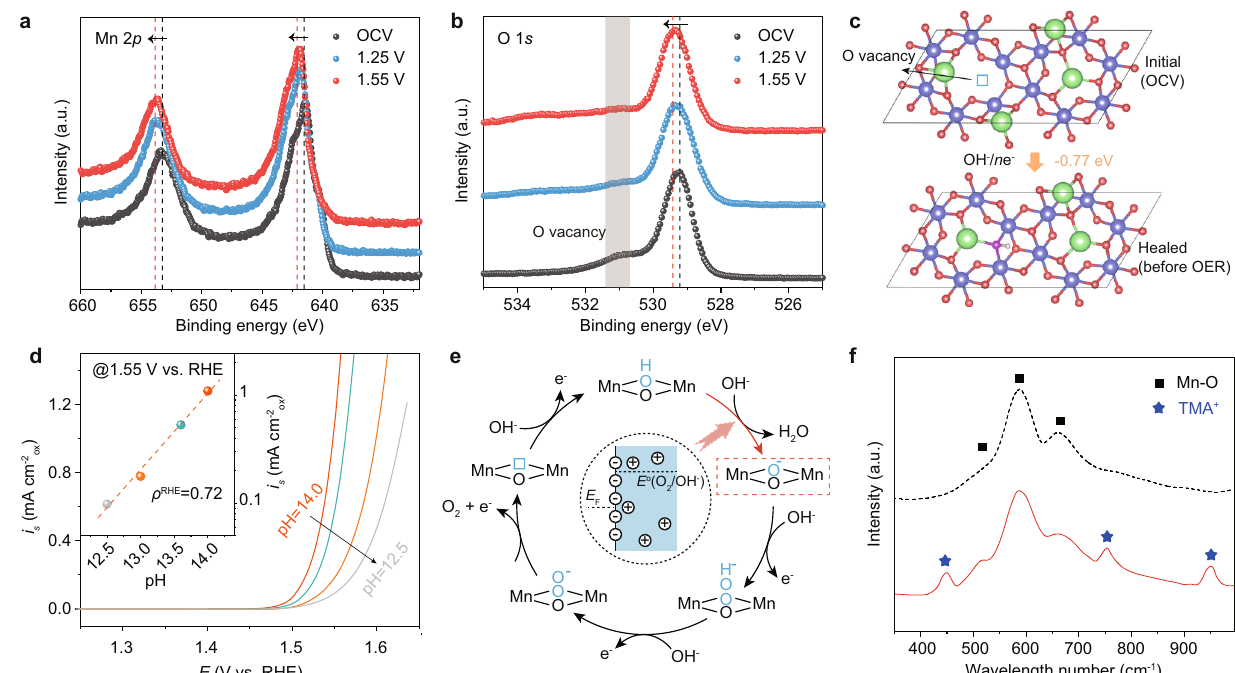
Fig. 5 Evidence of lattice oxygen as reaction site under OER conditions. In situ XPS spectra of Mn 2 p ( a ) and O 1 s ( b ) of NaMn 3 O 7 under open circuit, 1.25 and 1.55 V (versus RHE). c The process of oxygen vacancy re fi lling under 1.23 V and the associated energy barrier. d pH dependence of the OER activities of NaMn 3 O 7 . The inset is the proton reaction order estimated by ρ RHE = ( ∂ log( i )/ ∂ pH), with ρ RHE and i being the proton reaction order and current density at a fi xed potential of 1.55 V vs. RHE. e Schematic OER pathway of acid – base nucleophilic attack involving the rate-limiting proton transfer decoupled from electron transfer step. The inset illustrates the formation of negatively charged oxide surface when equilibrated with the electrolyte. f Raman spectra of NaMn 3 O 7 electrodes. These electrodes were respectively operated at 1.55 V versus RHE in 1 M KOH (black line) and TMAOH (red line) solution, then were thoroughly washed by rinsing with high-purity water and acetone for ex situ Raman spectroscopy shown in Fig. 5c, OH − (aq.) tends to spontaneously re fi ll the oxygen vacancy sites of Na x Mn 3 O 7 under 1.23 V vs. RHE. From Pourbaix diagram (Supplementary Fig. 21), the surface termina- tion of Na x Mn 3 O 7 shows the stoichiometric composition under electrochemical OER conditions. Accompanied by the decreased